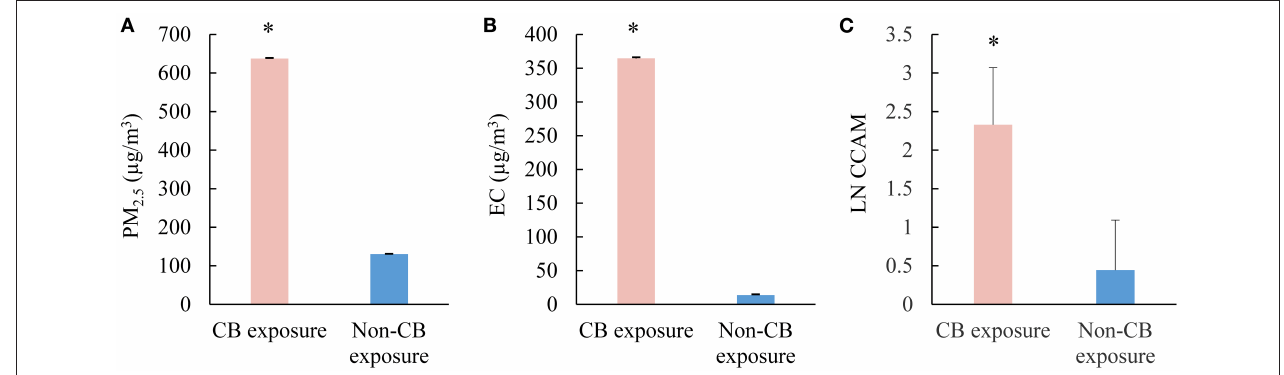
FIGURE 1 | Exposure assessment of CB packers and non-CB packers. (A) Concentrations of PM 2.5 in the work shop ( µ g/m 3 ); (B) concentrations of elemental carbon in the work shop ( µ g/m 3) ; (C) the levels of CCAM in the participants. CB, carbon black; PM 2.5 , particulate matter with aerodynamic diameters < 2.5 µ m; LN CCAM, natural log transformed carbon content in airway macrophage. * p < 0.05.